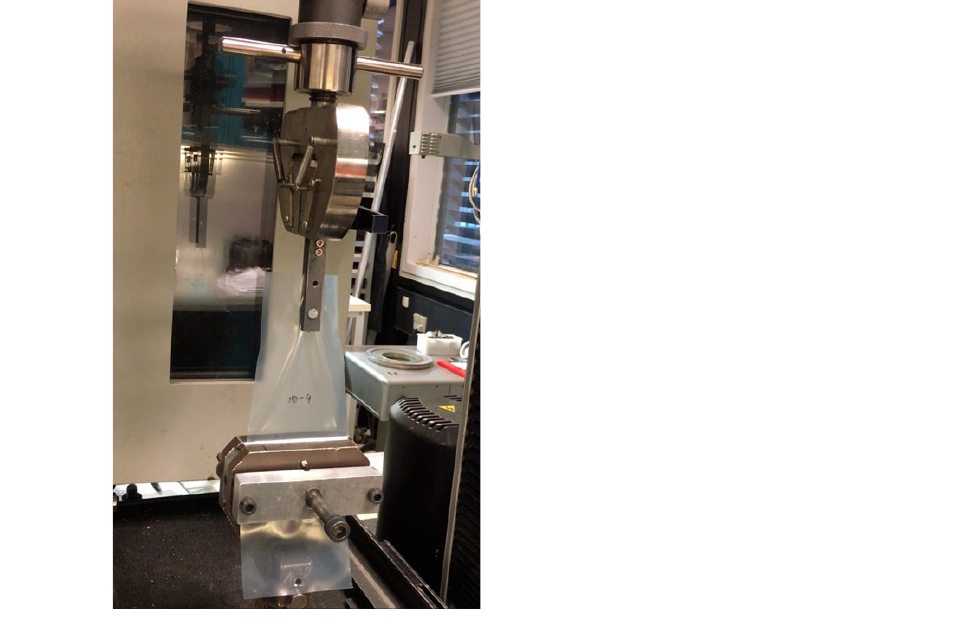
Figure 3. Tensile testing in a sample fixture perforated with a mandrel arranged for the purpose.